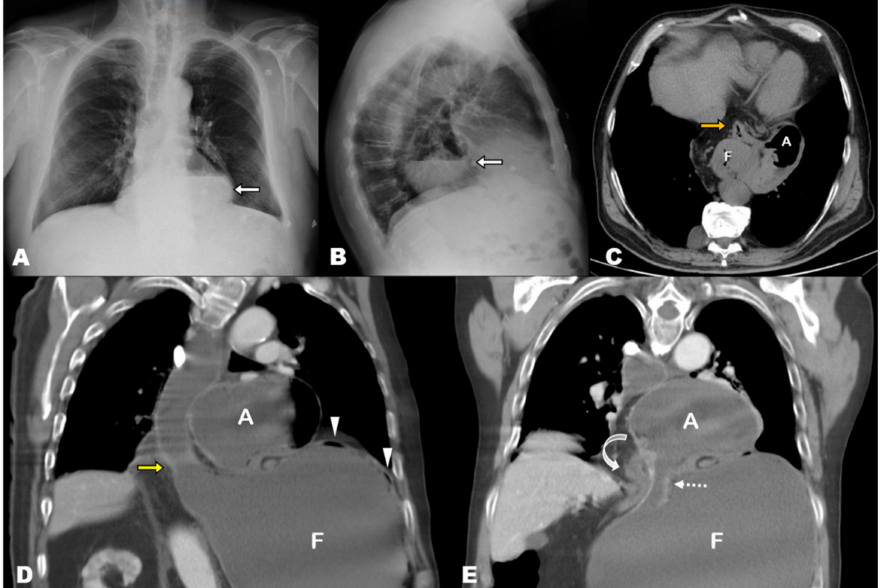
Figure 1. ( A , B ) Chest radiography 3 years prior to acute presentation, posteroanterior and lateral views. Large retrocardiac round radiolucency containing an air-fluid level, which corresponds to a sliding hiatal hernia containing the entire stomach. ( C ) Axial-oblique MPR non-contrast CT image corroborates the presence of the entire stomach and first duodenal segment (orange arrow) in the mediastinum. ( D , E ) Contrast-enhanced at the acute presentation, coronal-oblique MPR views. Marked dilatation of the stomach and esophagus. The antrum (A) lies above the diaphragm, and the fundus (F) is herniated through the esophageal hiatus (yellow arrow). Note the hernia neck, dotted arrow in ( E ). The antropiloric junction originates from the posterior part of the antrum (bending arrow in ( E ) and lies to the right side of the esophageal hiatus. These findings indicate that the fundus, which was previously located in the mediastinum, re-herniated into the abdominal cavity, triggering the gastric volvulus. Note the absence of nasogastric tube, which could not be inserted in this